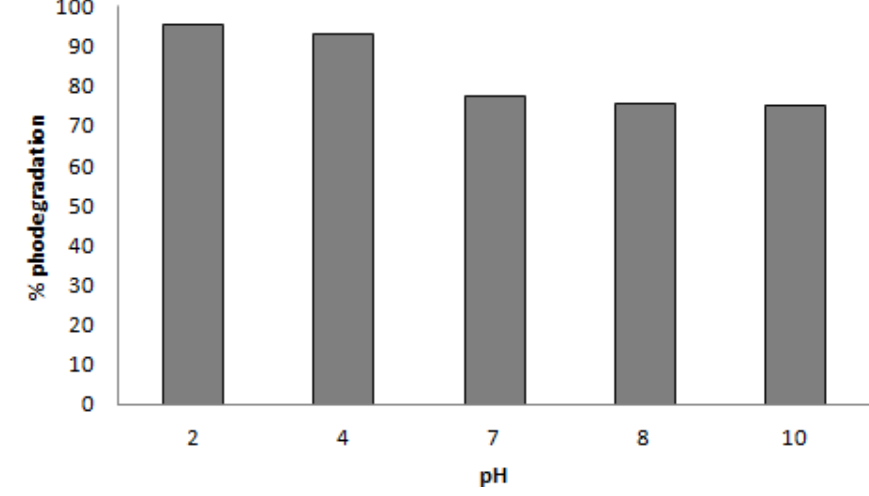
(0.1 g·L − 1 ) photodegradation efficiency of 30 mgL − 1 C.I Reactive Black 5 at Figure 5. TiO 2 different pH